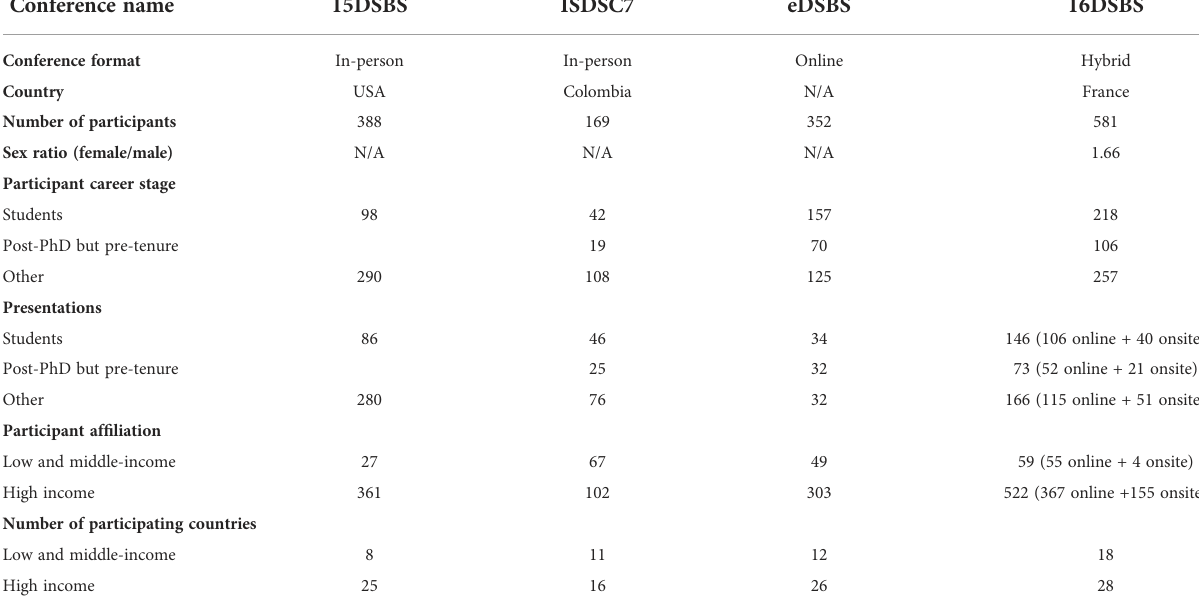
TABLE 3 Comparison between in-person, online and hybrid deep-sea biology meetings in terms of demographic composition by sex, career stage and country of institutional af fi